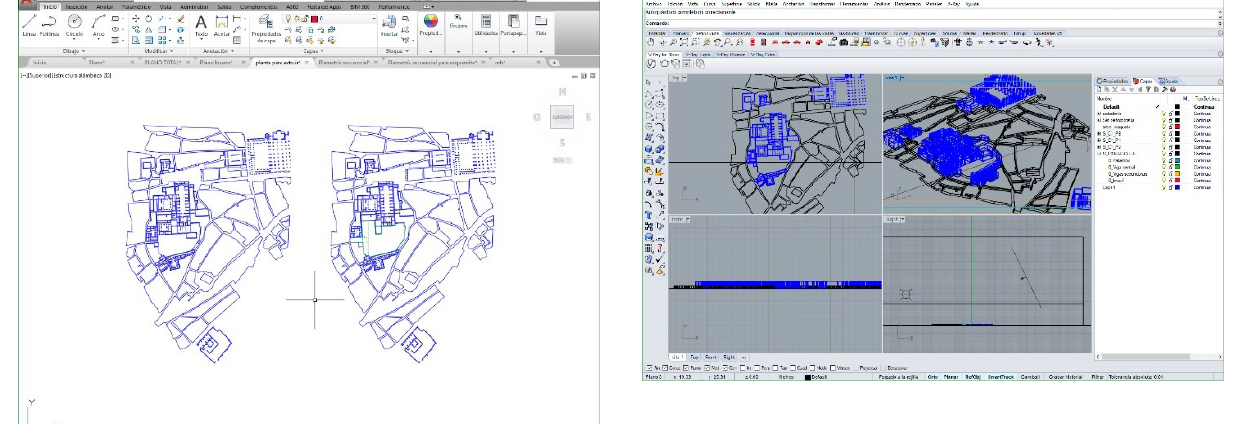
Figure 3. Rhinoceros 5.0 screenshot with 3D modeling prior to rendering (The authors,